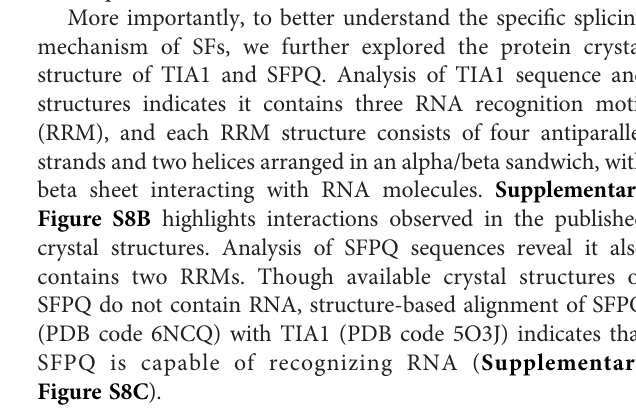
Figure S8A and Figure 7C ), and Cell Cycle analysis suggested that the overexpression of ADHFE1_203 inhibited S phase, while the overexpression of ADHFE1_207 inhibited G1 phase ( Figure 7D ). In addition, we observed that the overexpression of ADHFE1_203 signi fi cantly inhibited migration and invasion in Huh7 cell line ( Figure 7E ). Intriguingly, MTT and transwell